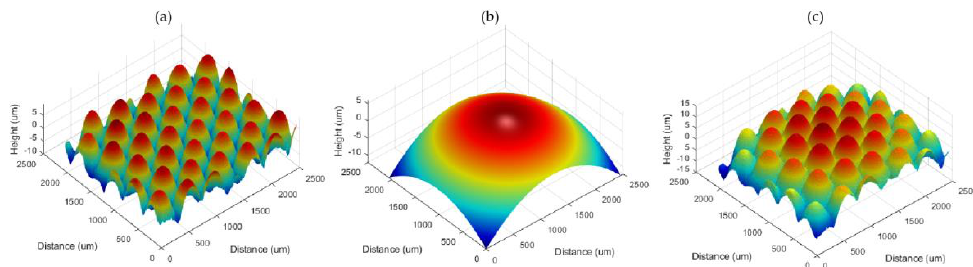
Figure 5. ( a ) Thickness information reproduced in the hologram is obtained from the transmission DHM. ( b ) Bottom surface information reproduced in the hologram is obtained from the reflection DHM. ( c ) The sample structure deduced from combination of bottom surface and thickness information.